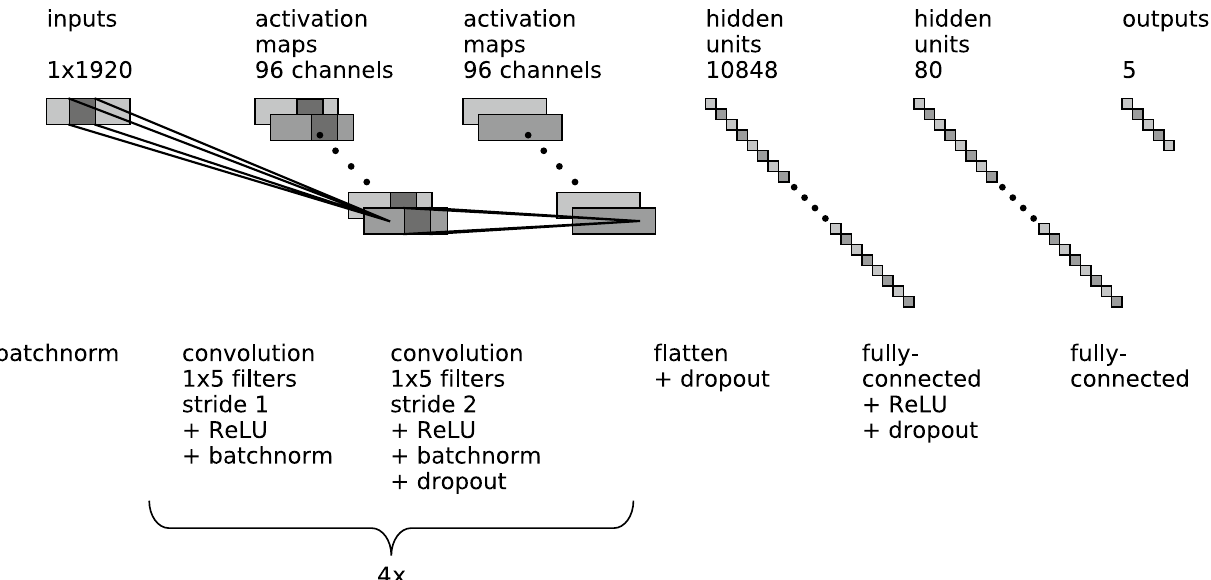
Figure 2. Network architecture. The feature extractor consists of 8 convolutional layers, and the output of the last convolutional layer is flattened (Flatten). EEG time series data is batch normalized (Batchnorm) before the first convolutional layer is applied. The classifier consists of two fully connected layers. A softmax layer translates the activations of the previous layer into class